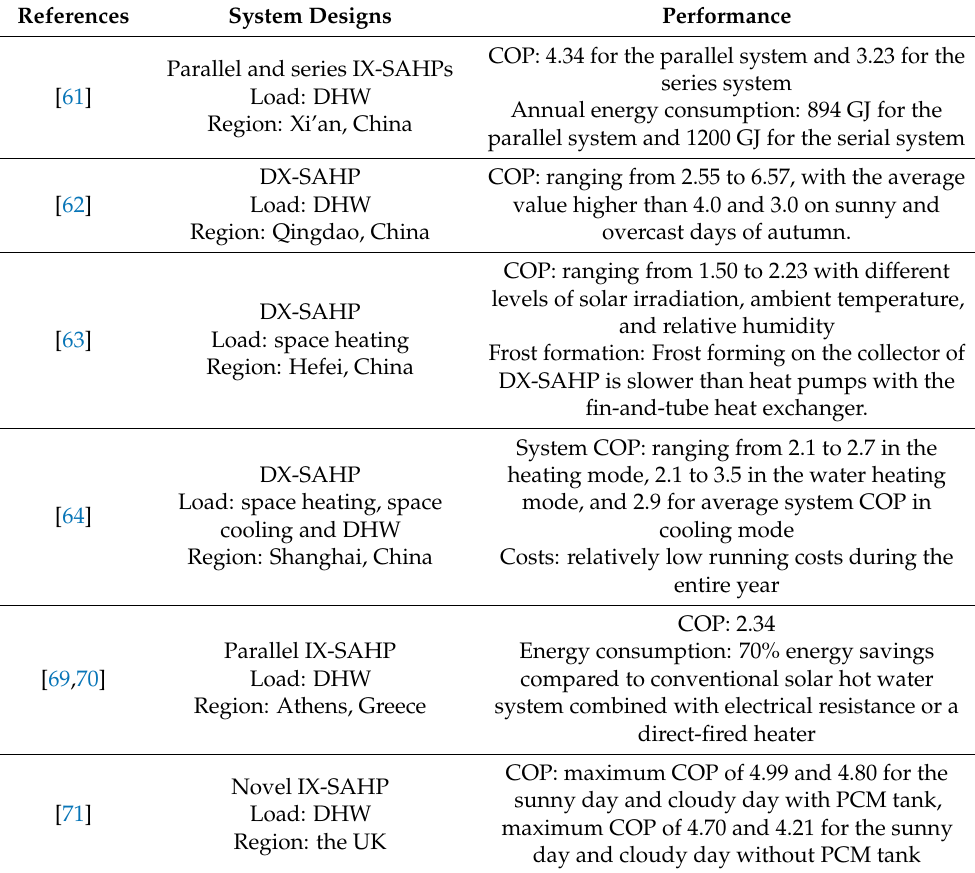
Table 4. Summary of studies of SAHP